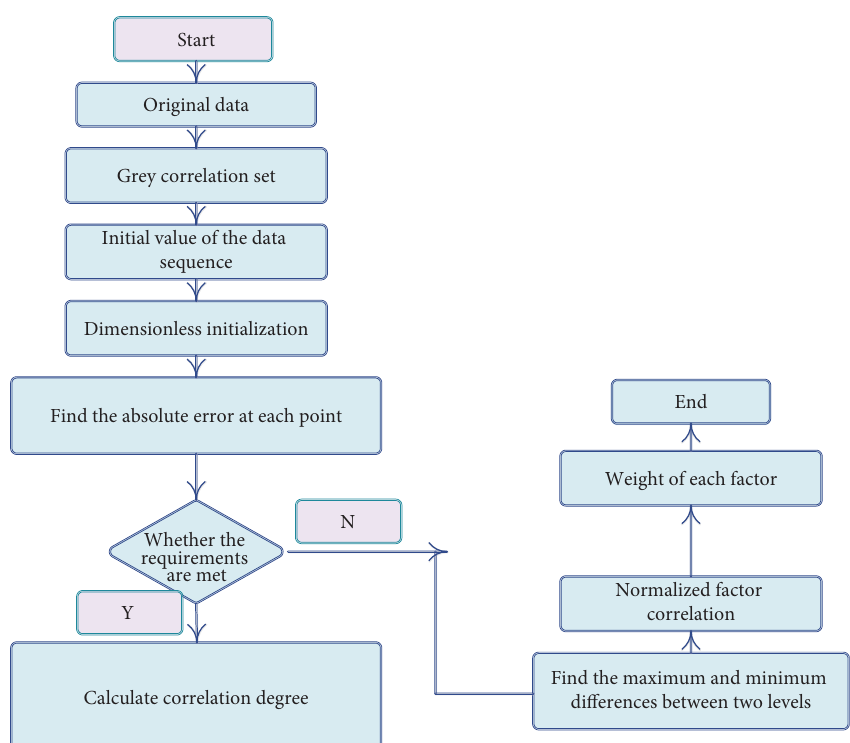
Figure 3: Grey correlation analysis flow chart of masonry model based on entropy